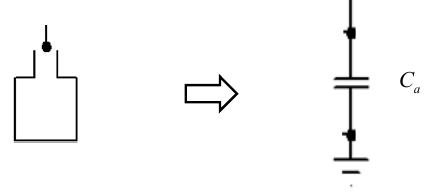
Figure 7. Tube model.